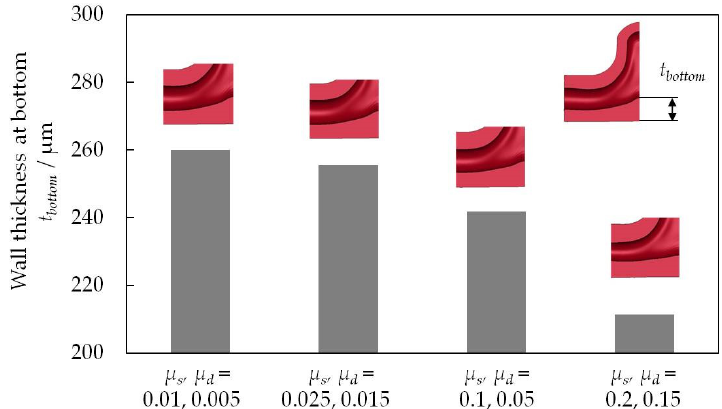
Figure 16. Effect of friction coefficient on wall thickness at bottom opposite branch part of a micro-T-shape tube ( p h = 50 MPa, ∆ L 1 = 150 µ m).